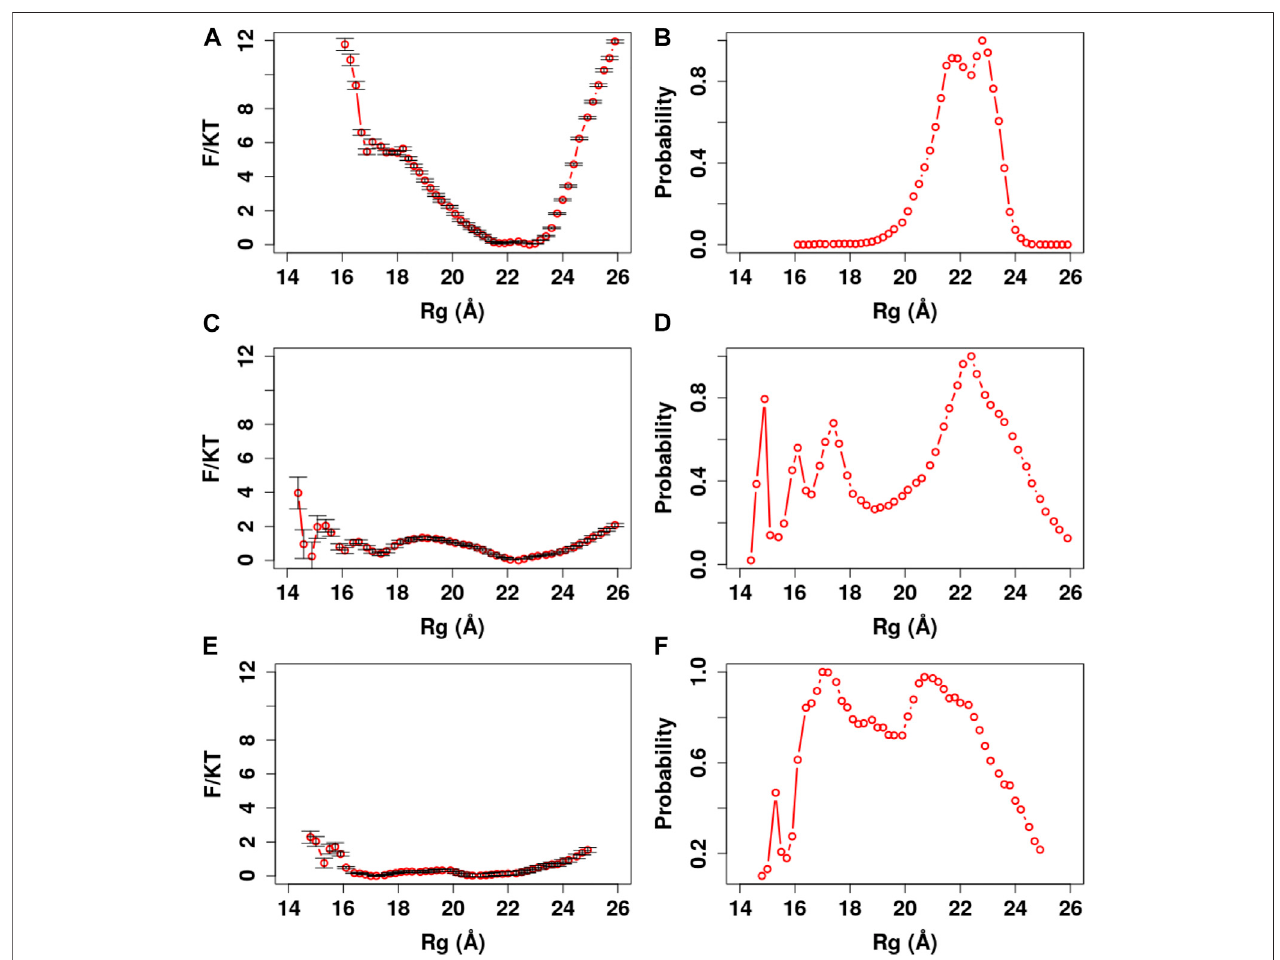
FIGURE4| PMF and Rgdistribution oftheCa 2+ -CaM modelsusing theglobal memoryweightofdifferent orderofmagnitudes. Thememory weight parameters of the Ca 2+ -CaM models are listed in Table 2 (model I; λ FM (cid:1) 1, 0.1, 0.01, and W m n (cid:1) 1). (A, C, E) The reweighted free energy pro fi le as a function of Rg from US simulations with λ FM (cid:1) 1, 0.1, 0.01, respectively. (B, D, F) The probability distribution as a function of Rg. The standard errors in the PMF are